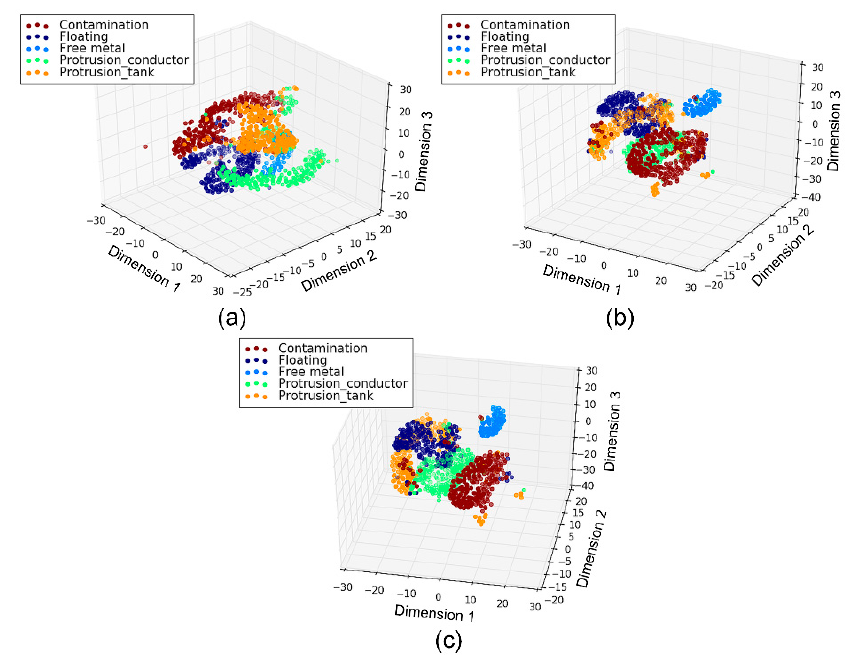
Figure 18. Visualization of the learned features for the defect types only: ( a ) Temporal channel; ( b ) frequency channel; ( c ) texture channel.